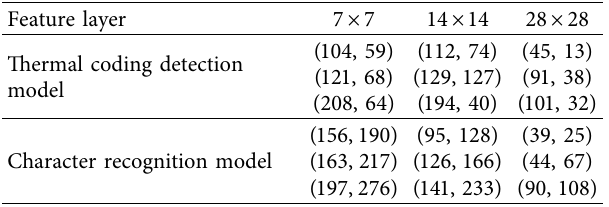
Figure 4: Image preprocessing effect: (a) original thermal inkjet coding image and (b) enhanced image results. Table 3: K -means clustering results of prior box. Table 4: Comparison of different deep learning detection models.